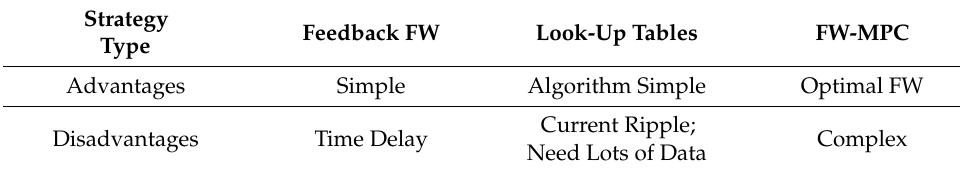
Table 1. Flux-weakening drive for